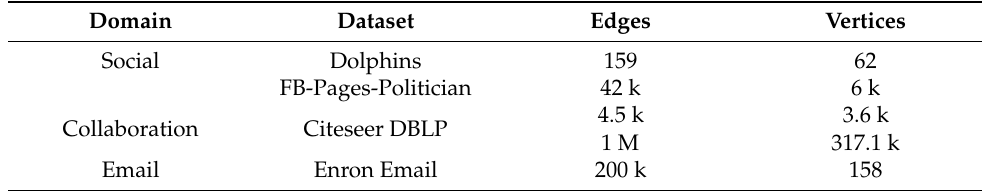
Table 1. Real-world network datasets used in an experiment of the HCD